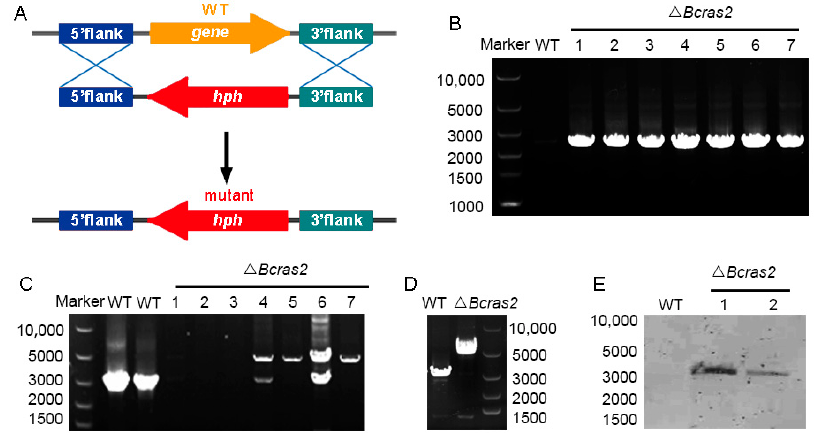
Figure 1. Generation of ∆ Bcras2 mutants: ( A ) Strategy for constructing the ∆ Bcras2 deletion mutants . hph, the hygromycin resistance cassette. ( B ) PCR diagnosis of ∆ Bcras2 mutants. ( C , D ) Diagnosis of the homozygotes of ∆ Bcras2 mutants. The picture showed the results from two PCR tests. ( E ) Southern blot analysis of the wild-type (WT) and ∆ Bcras2 strains. Numbers represent different strains.